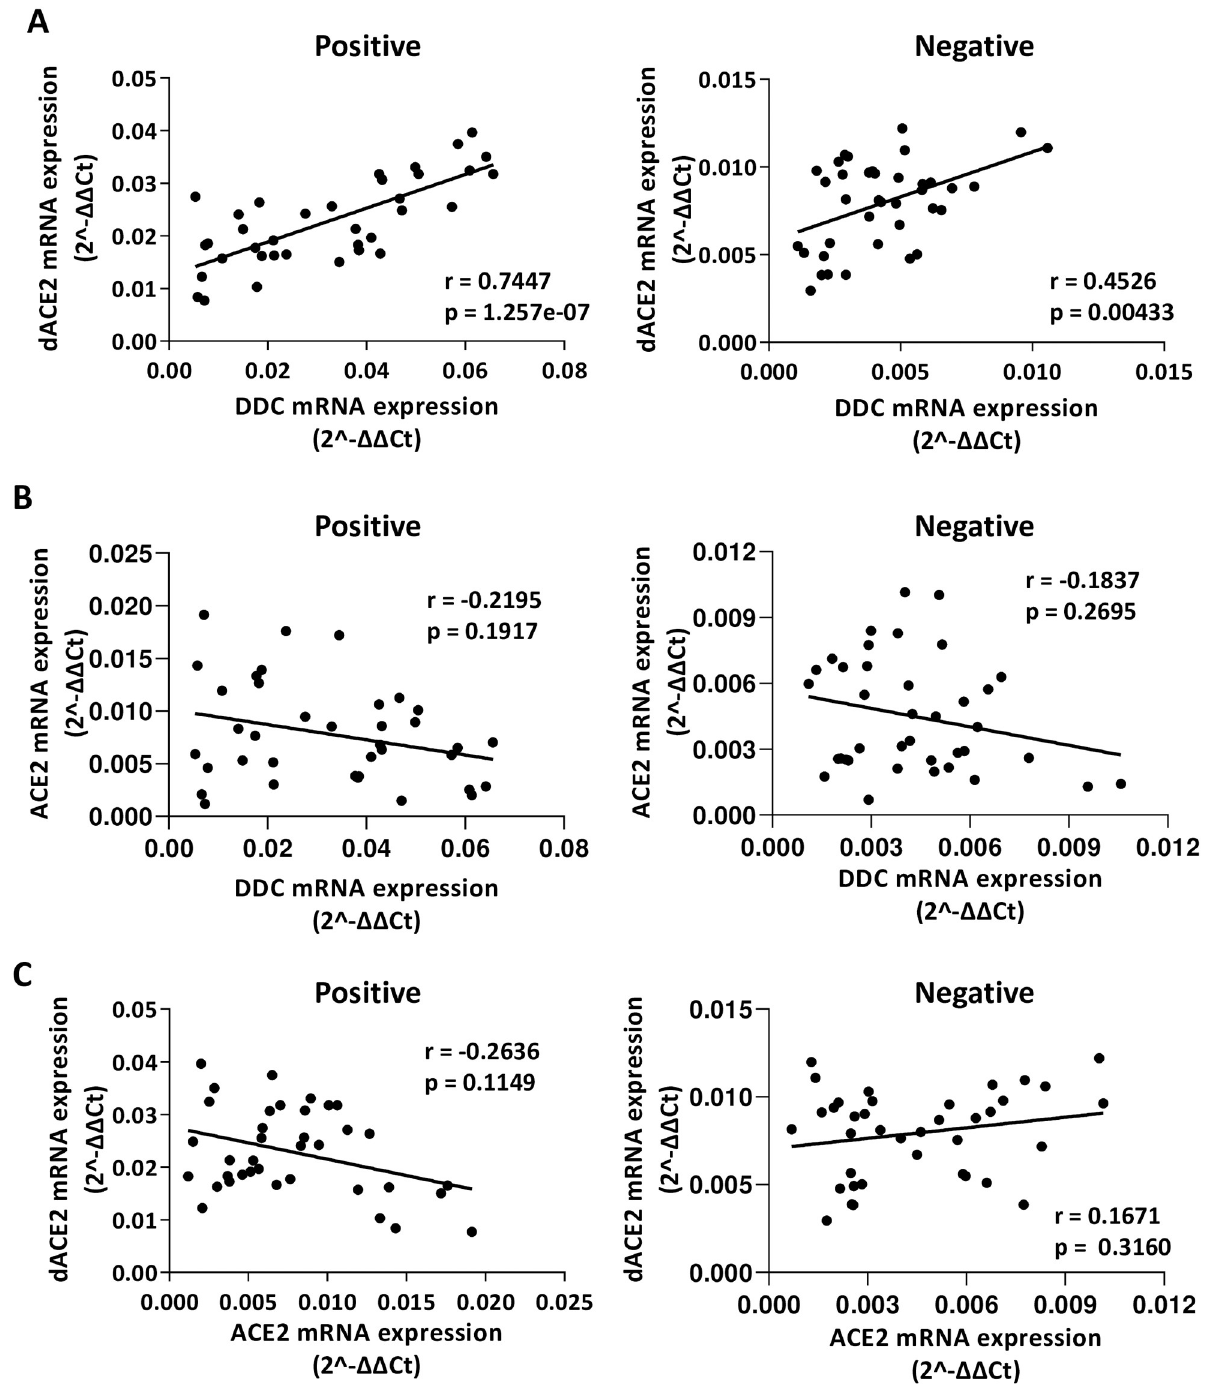
Fig 6. Correlation among DDC , dACE2 and ACE2 gene expression levels in SARS-CoV-2-positive and negative nasopharyngeal swab samples. XY scatter plot and fitted linear regression lines of the mRNA levels of ( A ) DDC versus dACE2 , ( B ) DDC versus ACE2 and ( C ) dACE2 versus ACE2 , in positive (left) and negative (right) samples. Pearson’s or Spearman’s correlation coefficient ( r ) and p values ( p ) were calculated.